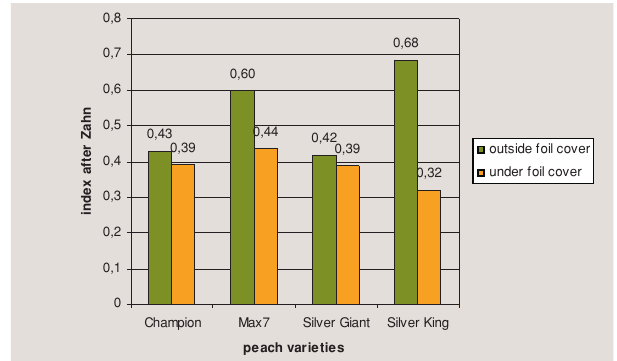
0,430,600,420,680,390,440,390,3200,10,20,30,40,50,60,70,8ChampionMax7SilverGiantSilverKing peachvarieties i nd exa ft e r Z a hn outsidefoilcoverunderfoilcover Figure 4. The Zahn index of 8 year old peach trees grown under foil cover